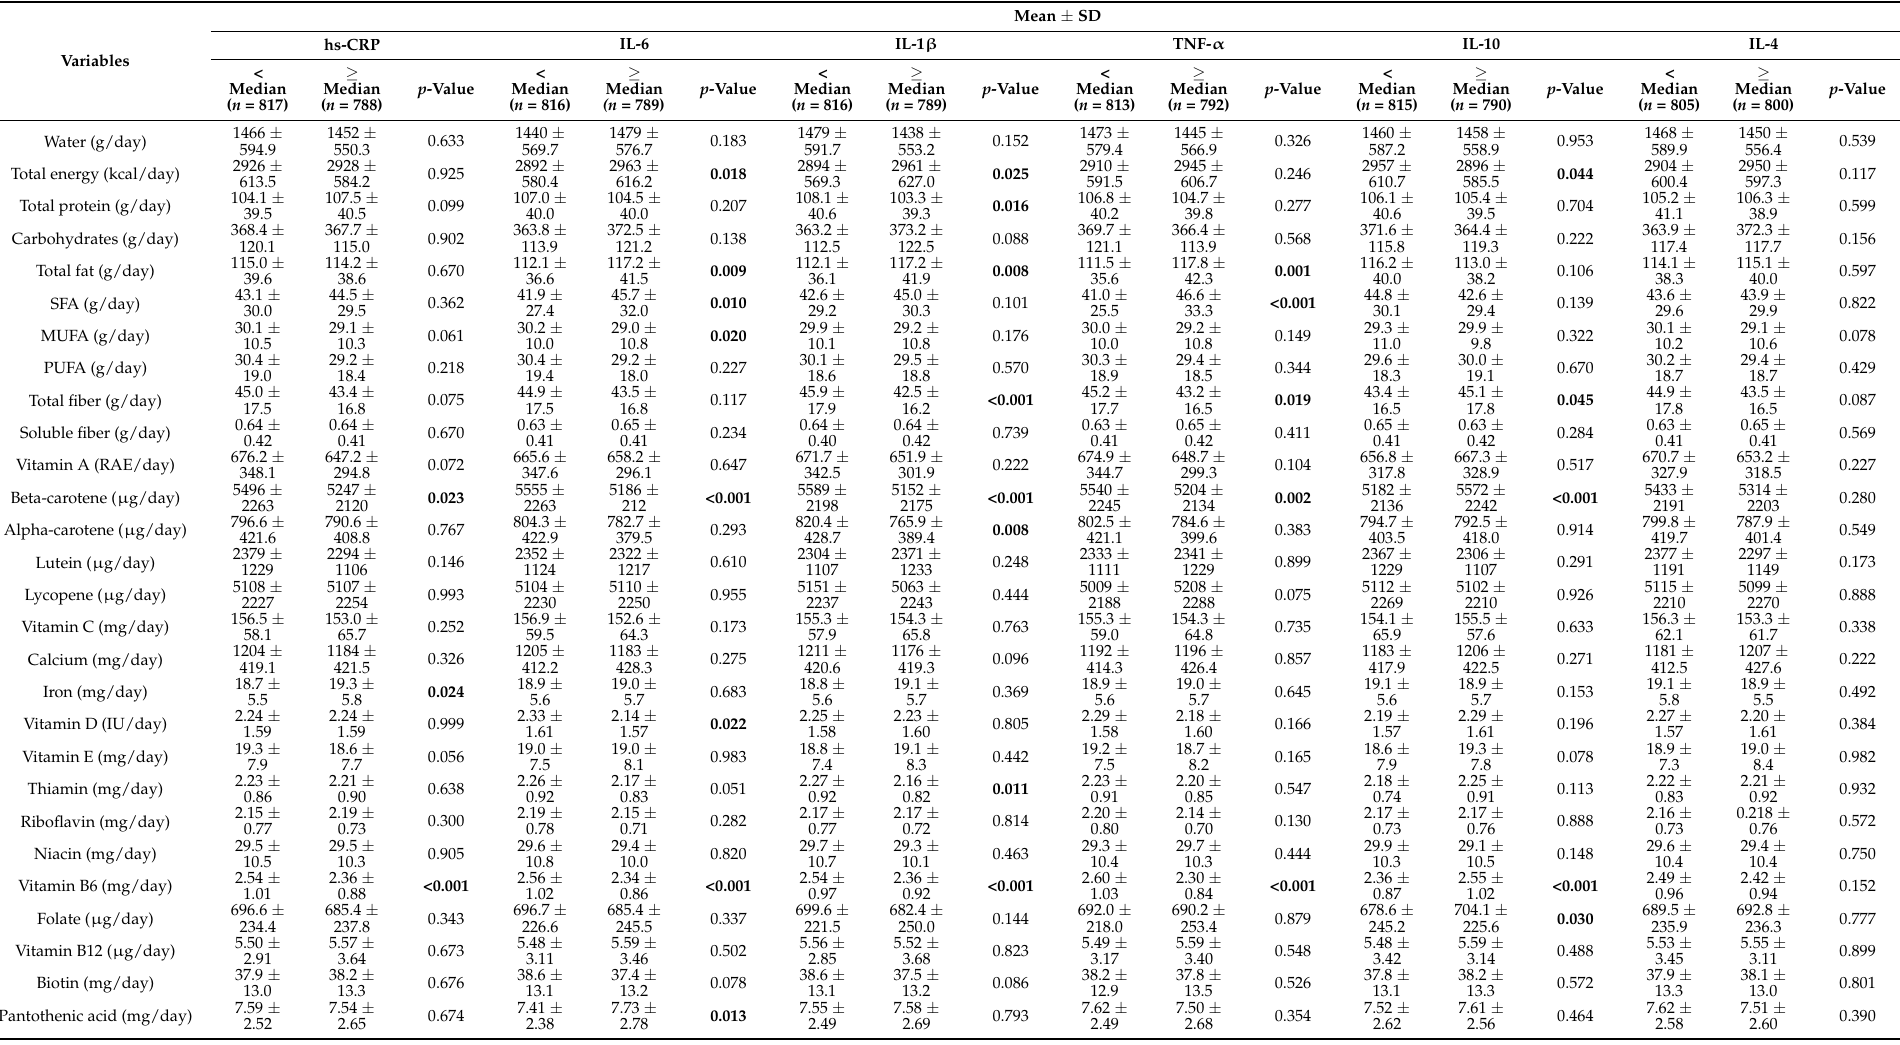
Table 4. Comparison (mean ± SD) of macro- and micronutrient intakes in various groups (lower and higher than the median) according to inflammatory markers a